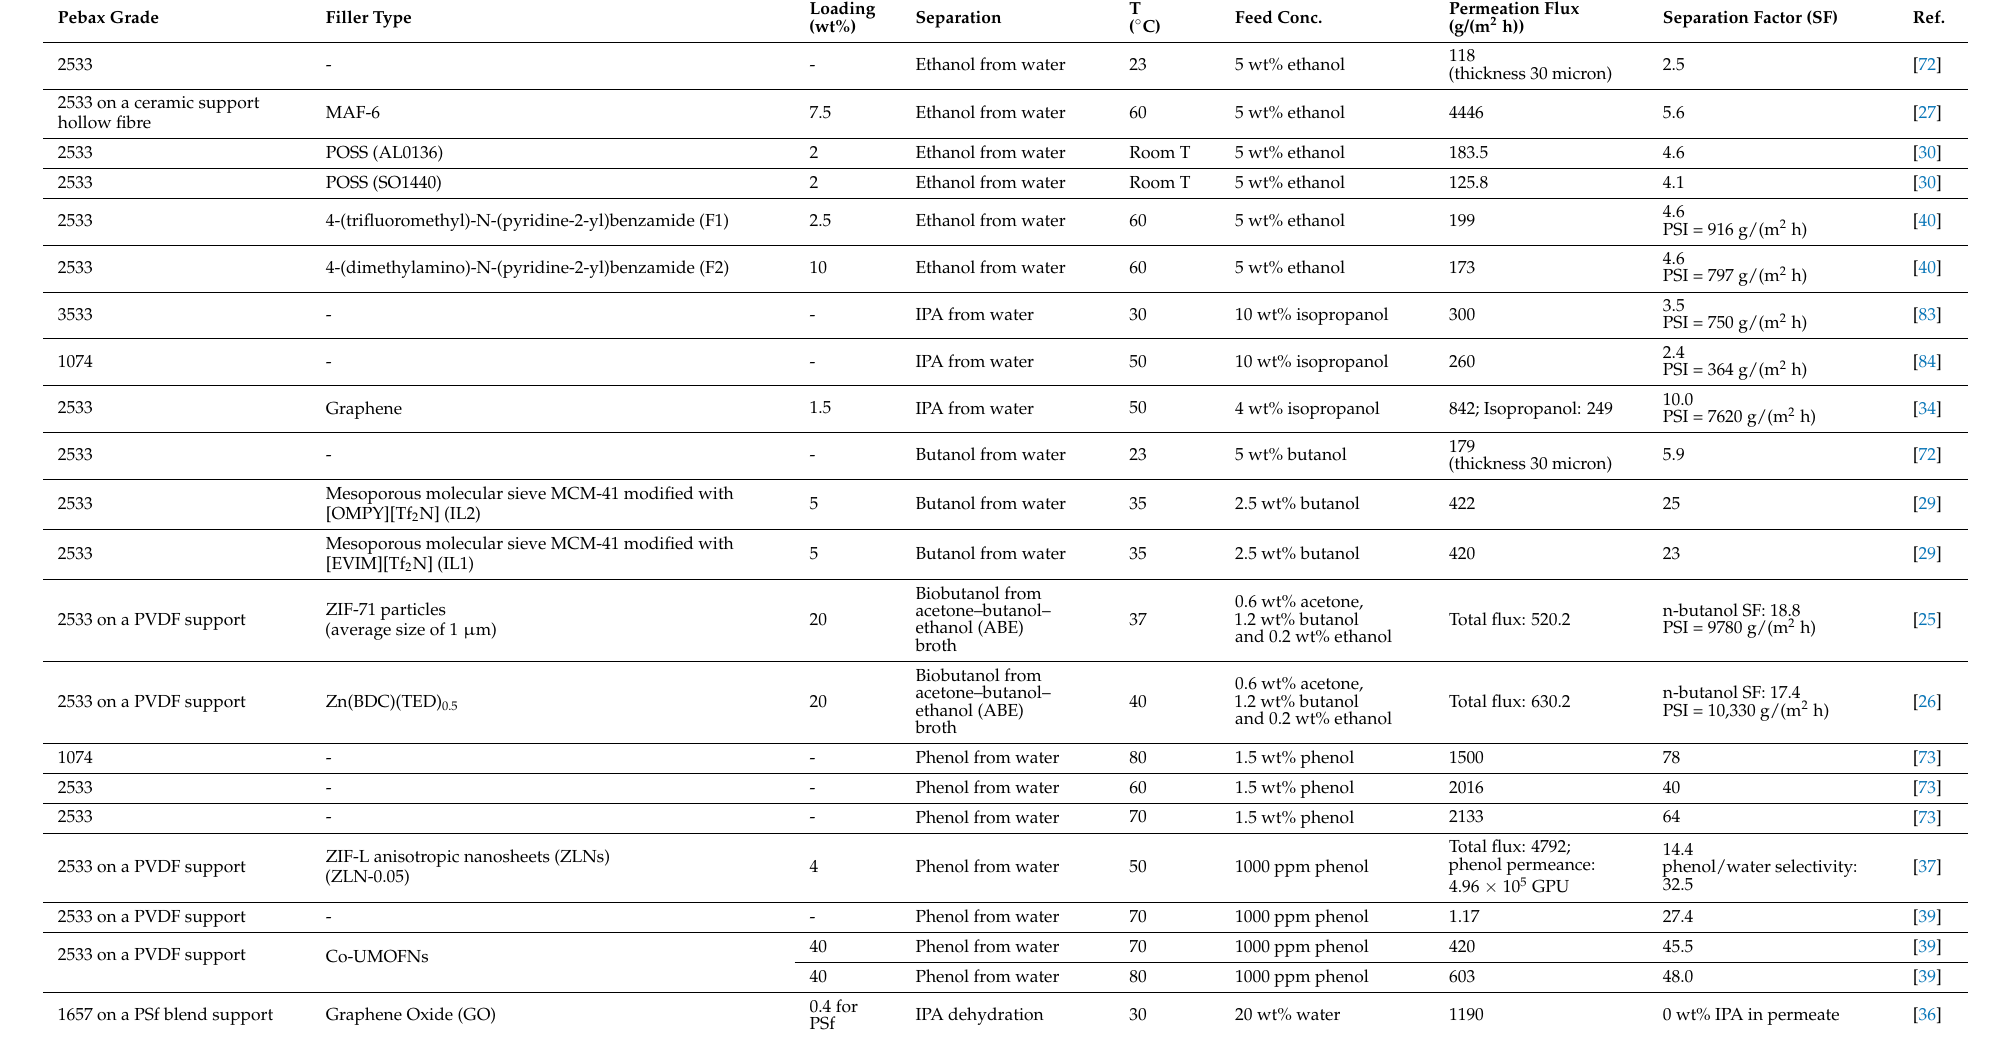
Table 5. Pervaporation performance of Pebax-based MMMs for separating alcohols or phenol from aqueous